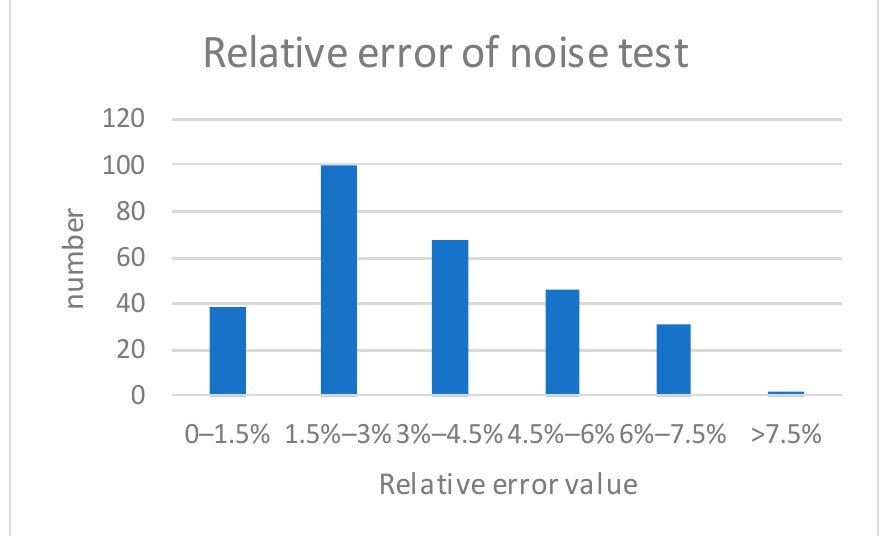
Figure 5. Distribution of relative error intervals.